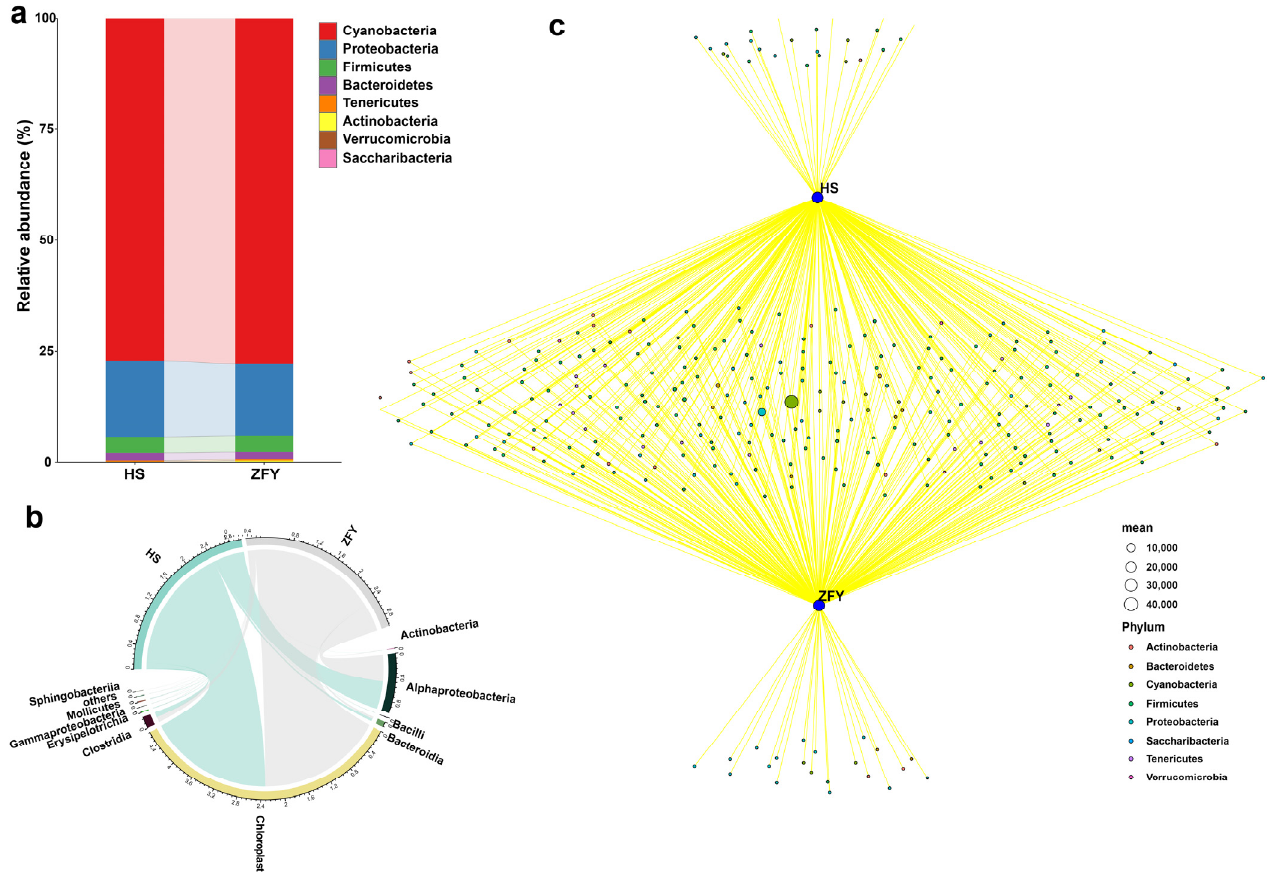
Figure 2. Composition of the endophytic bacterial communities in HS and ZFY. ( a ) Relative abun- dance of phyla in the bacterial communities. ( b ) Composition of class of bacterial communities. ( c ) Network Venn diagram showing positive associations between di ff erent species (HS and ZFY) and signi fi cantly associated bacterial phyla.